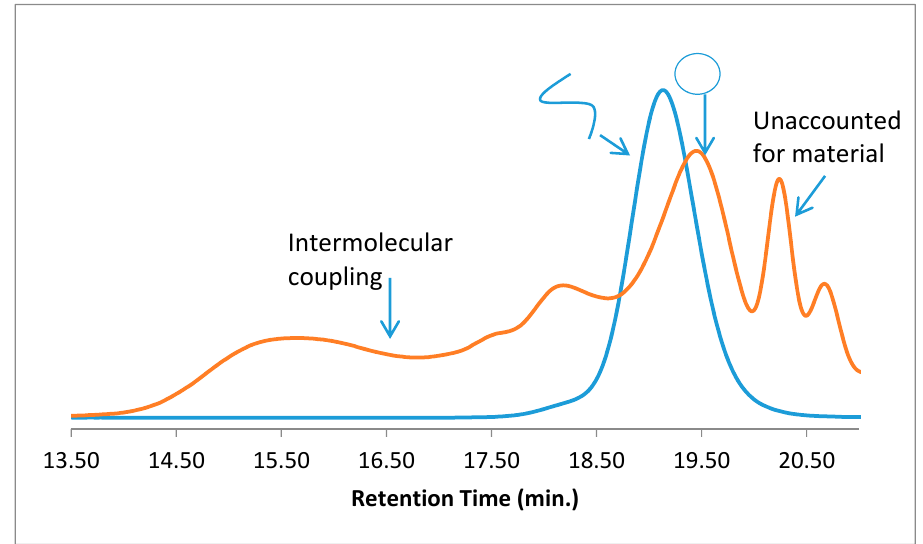
Figure 2. GPC traces of BrPSBr precursor (orange) and unpurified product of intramolecular RTA ‐ ATRC reaction (orange). RTA ‐ ATRC reaction conducted at 60 °C and [BrPSBr] of 0.1 mM. Precursor characteristics: M n : 3100 Da, M p : 3250 Da, Đ : 1.09. Cyclic product characteristics: M p : 2600 Da, <G> = 0.8.